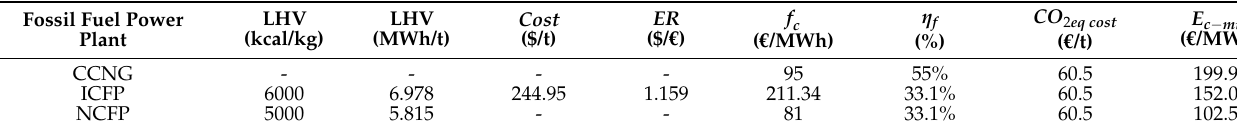
Table 1. E c − min for each power plant using fossil fuels (FFPP).